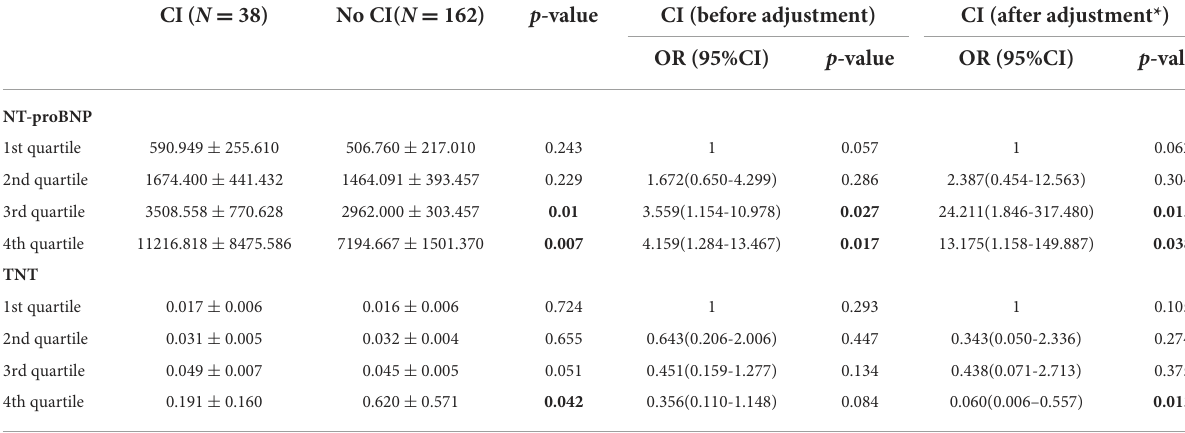
TABLE 3 Association between cardiac markers (quartiles) and